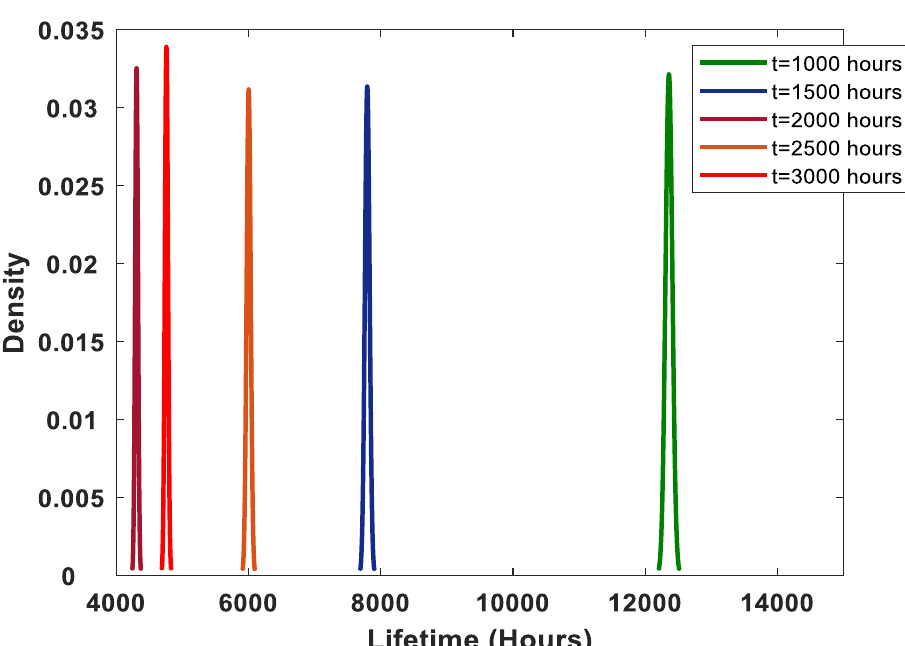
Figure 5. RUL density curve at a different time of field degradation